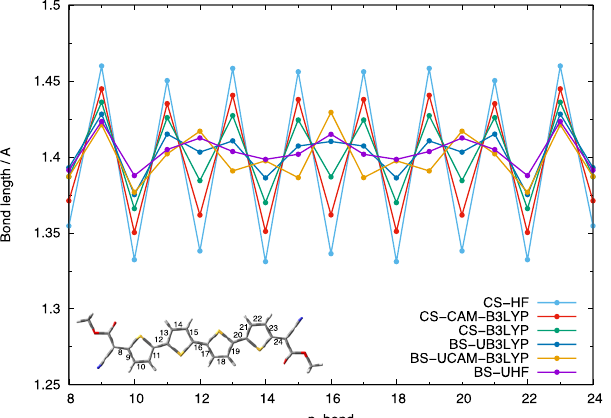
Figure 2. EsQ4 CC bond lengths calculated at CS-HF (cyan), CS-CAM-B3LYP (red), CS-B3LYP (green), BS-UB3LYP (blue), BS-UCAM-B3LYP (orange) and BS-UHF (purple) geometries. Bottom left: definition of bond numbers.